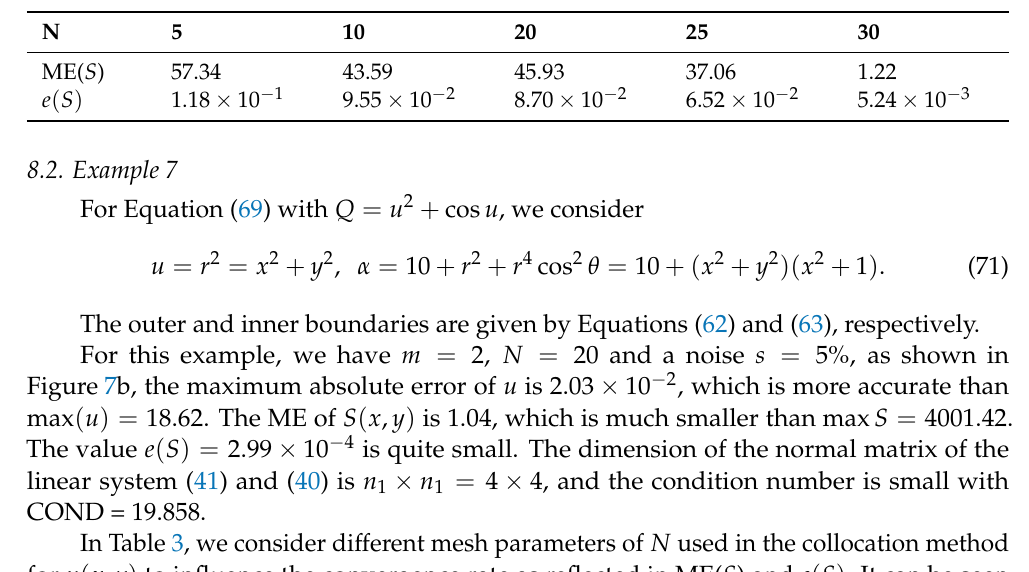
Table 2. For example 6, the influence of mesh parameter N on ME( S ) and e ( S )